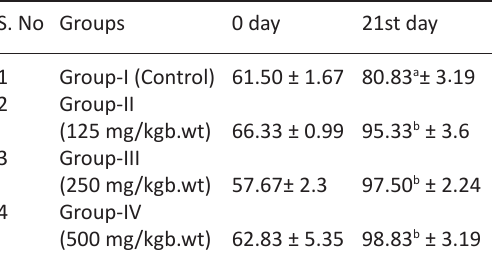
Table 1. Mean body weight (g) of Wistar albino rats of different Groups